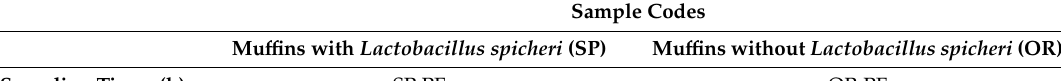
Table 4. Codification and sampling times during sourdough fermentation with Lsp (SP) and without Lsp